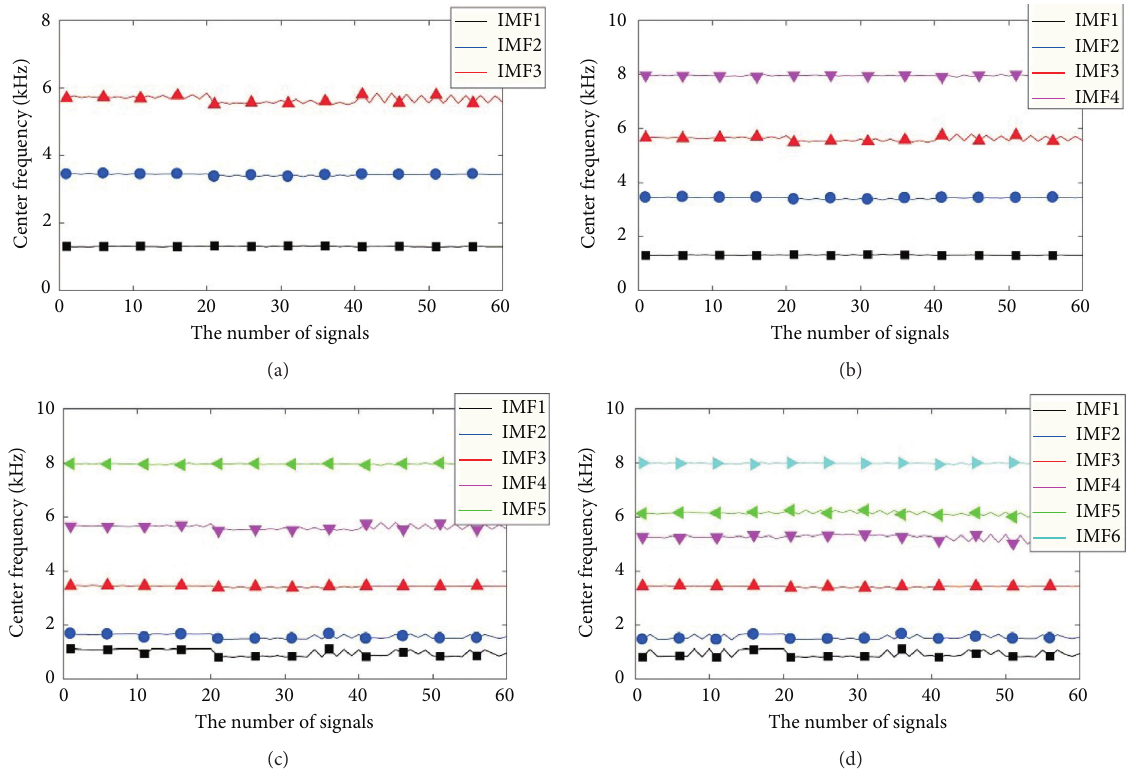
Figure 12: enter frequency distribution of 60 samples under left 1-cylinder misfire. (a) K � 3. (b) K � 4. (c) K � 5. (d) K �